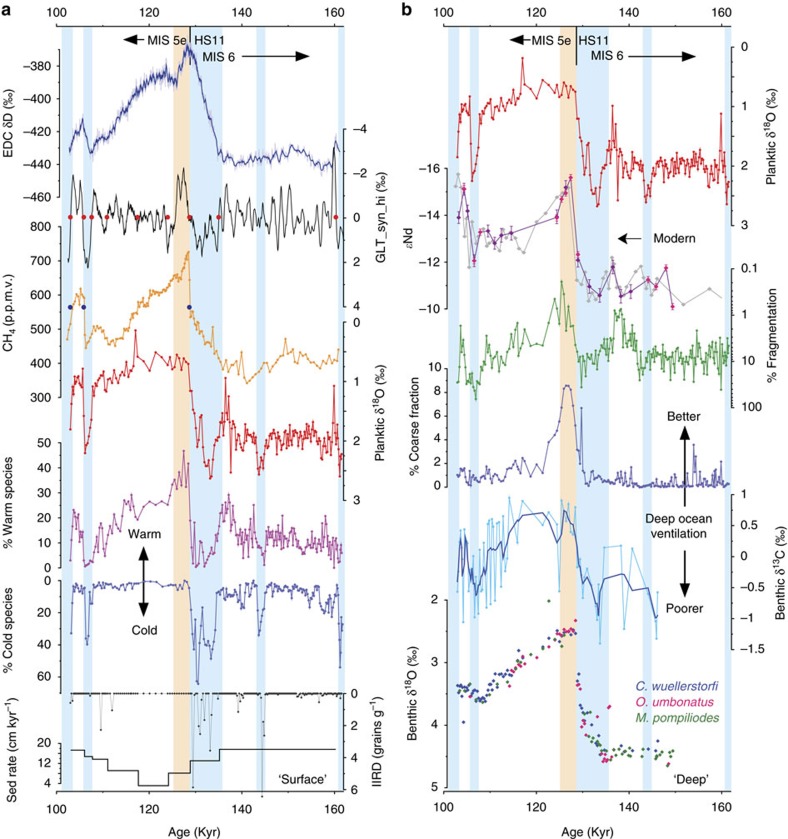
Surface and deep records from ODP Site 1063.(a) (from top to bottom) Antarctic ice core temperature proxy, EDC (EPICA Dome C) δD (ref. 1); GLT_syn_hi, a proxy for anomalous northward heat transport associated with the bipolar seesaw (derived from EDC δD)13; atmospheric CH4 from EDC (ref. 69; all other records are from ODP 1063) planktonic δ18O measured on G. inflata; percentage of warm foraminiferal species (see text); percentage of cold water species; number of IRD grains g−1; implied sedimentation rate. Filled blue and red circles are tuning points between site 1063 and CH4 and or GLT_syn_hi, respectively (Methods section). (b) (from top to bottom); planktonic δ18O; seawater ɛNd (pink symbols were measured by TIMS, purple by MC-ICP-MS, grey are results of ref. 17, error bars are 2σ, arrow is modern value at 1063); percentage of foraminiferal fragmentation; percentage of coarse (>63 μm) fraction; benthic δ13C (C. wuellerstorfi with 3 point running mean); benthic δ18O (C. wuellerstorfi, M. pompilioides (−0.15; Methods section) and O. umbonatus (−0.38)). Blue vertical boxes are cold intervals, pink box is our inferred overshoot of the AMOC.